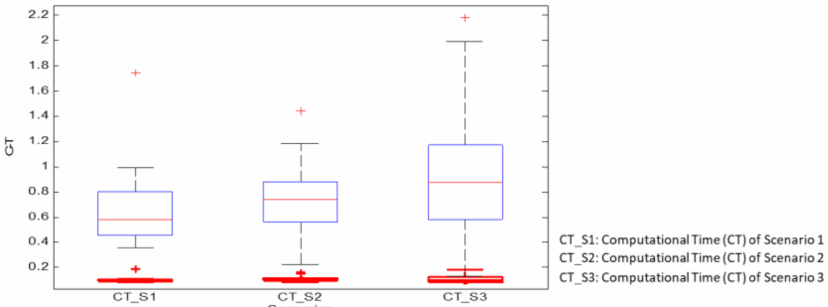
Figure 9. Performance (for ten subjects) of force estimation evaluated with training computing time for three scenarios (multimode approach is represented by the red line and ANN the blue